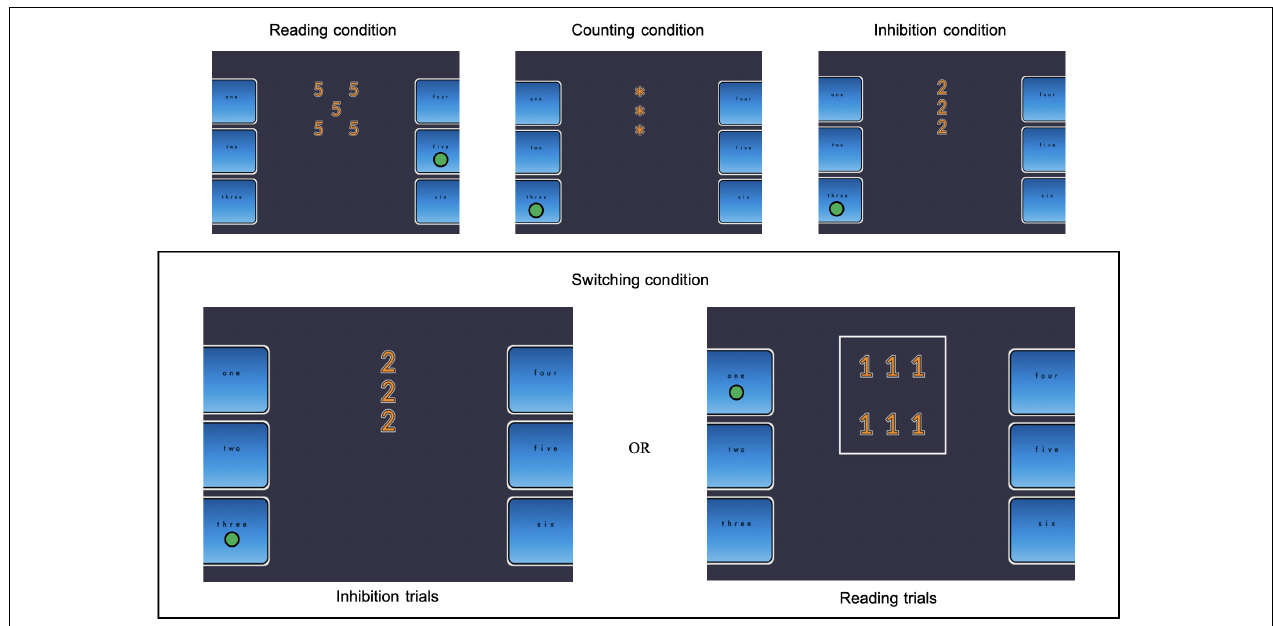
FIGURE 1 | Illustration of the Stroop task condition. The green circle represents the correct response for each condition trail.